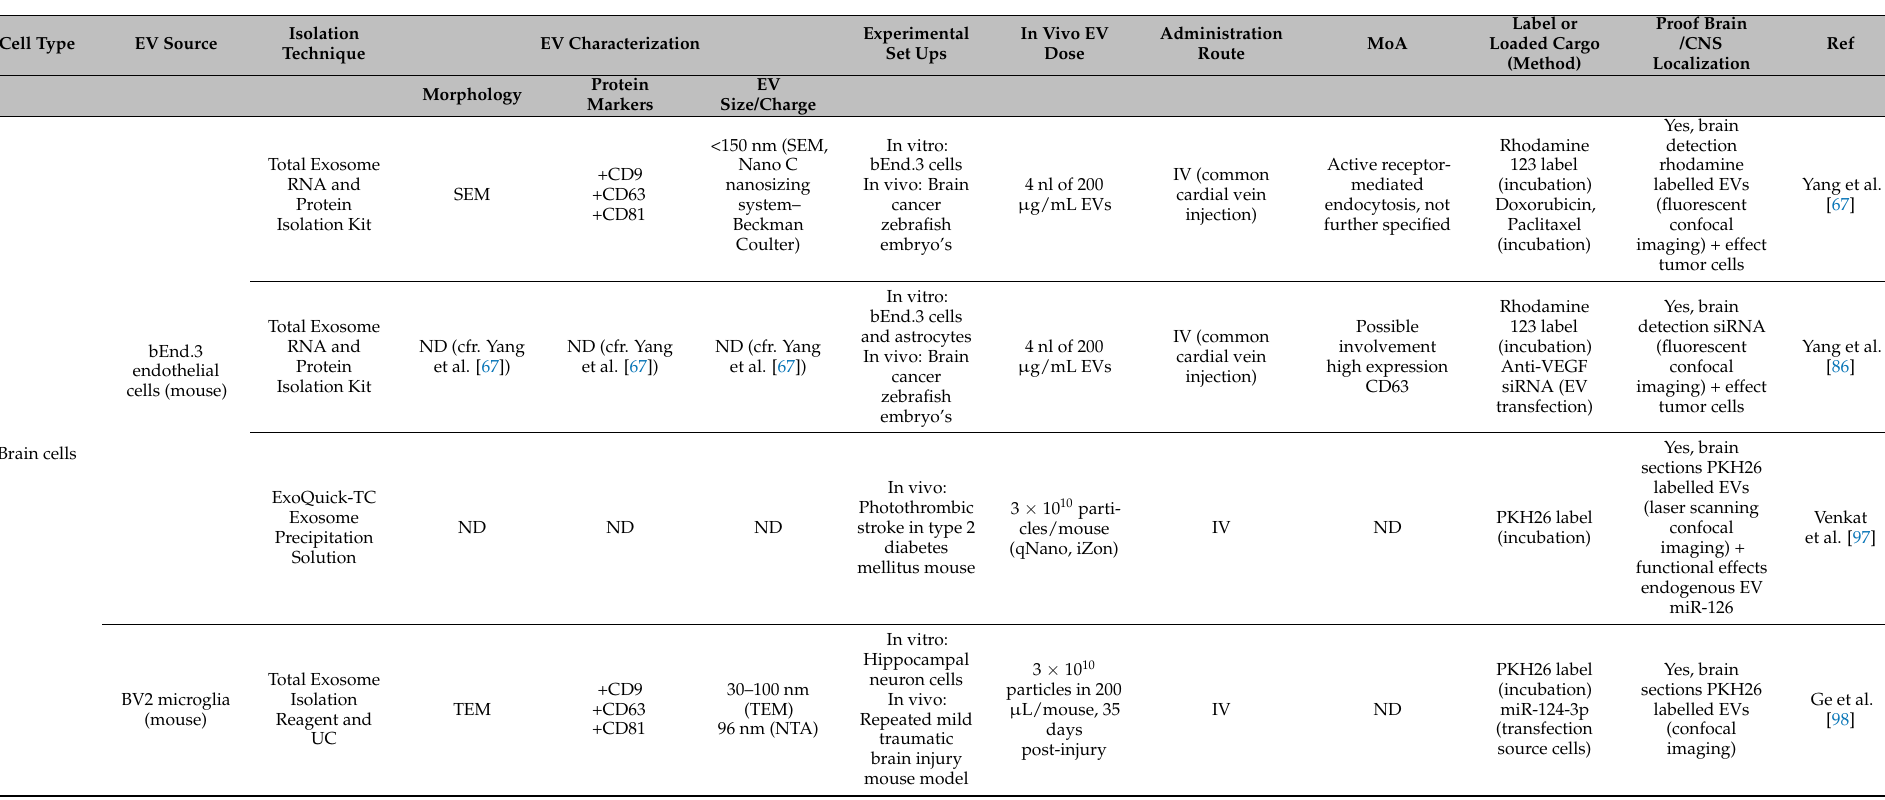
Table 1. Overview unmodified EVs applied for brain delivery. This table summarizes the experimental set ups and read-outs of the different studied EV types in brain delivery or brain disease EV treatment studies. Furthermore, information about the EV characterization based on the Minimal Information for Studies of EVs (MISEV) guidelines is included [3]. The “+” symbol in the protein marker column indicates the assessment of typical EV markers whereas the “-” symbol indicates the assessment of non-EV markers. Abbreviations: EV: extracellular vesicle; MoA: mode of action; ND: not determined; IV: intravenous; IP: intraperitoneal; IN: intranasal; UC: ultracentrifugation; SEC: size exclusion chromatography; TEM: transmission electron microscopy; AFM: atomic force microscopy; cpm: counts per minute; NTA: nanoparticle tracking analysis; DLS: dynamic light scattering; TRPS: tunable resistive pulse sensing; MRI: magnetic resonance imaging; CNP: cellular nanoporation; IVIS: in vivo imaging system; SRM: label-free selective reaction monitoring; Dil: 1,1 (cid:48) -Dioctadecyl-3,3,3 (cid:48) ,3 (cid:48)